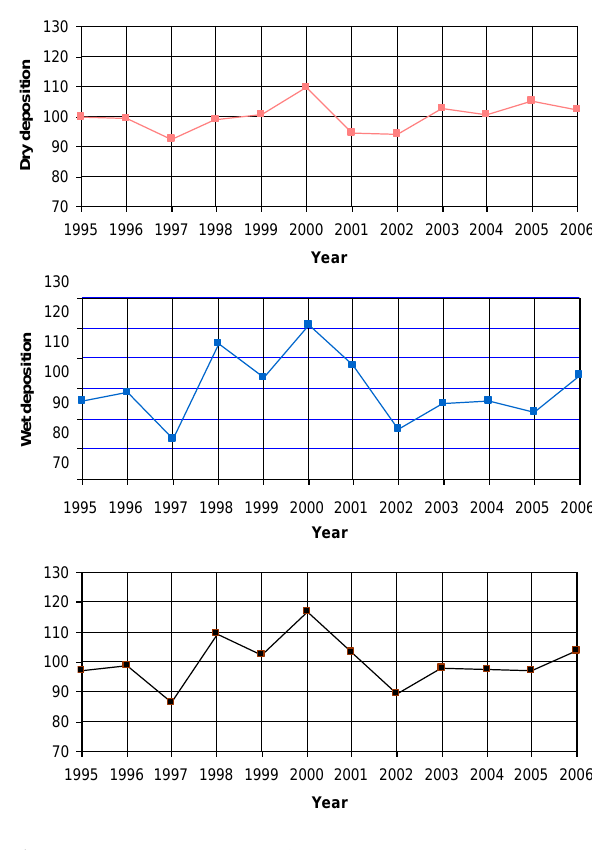
Fig. 13. Annual deposition of dry, wet and total nitrogen to the Baltic Sea basin for each year of the period 1995–2006 in % of the average value over the entire period. Results of the model run with constant emissions from 2006 and variable meteorology.